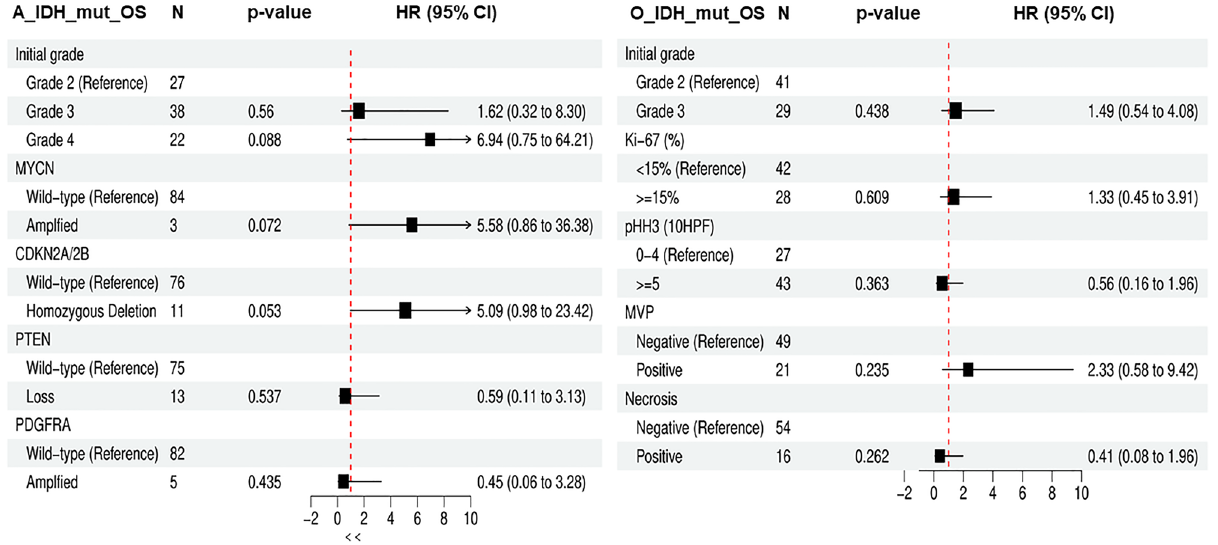
Figure 7. The hazard plot of various grade and genetic parameters in A_IDH_mut and O_IDH_mut. In A_IDH_mut, grade and CDKN2A/2B were statistically significant and MYCN -amplified tumor also were statistical significance, however, PTEN loss and PDGFRA amplification did not affect on the biological behavior of A_IDH_mut. In O_IDH_mut, the higher grade the higher HR, but it does not have statistical significance in this study ( OS overall survival, N number of cases, HR hazard ratio, MVP microvascular